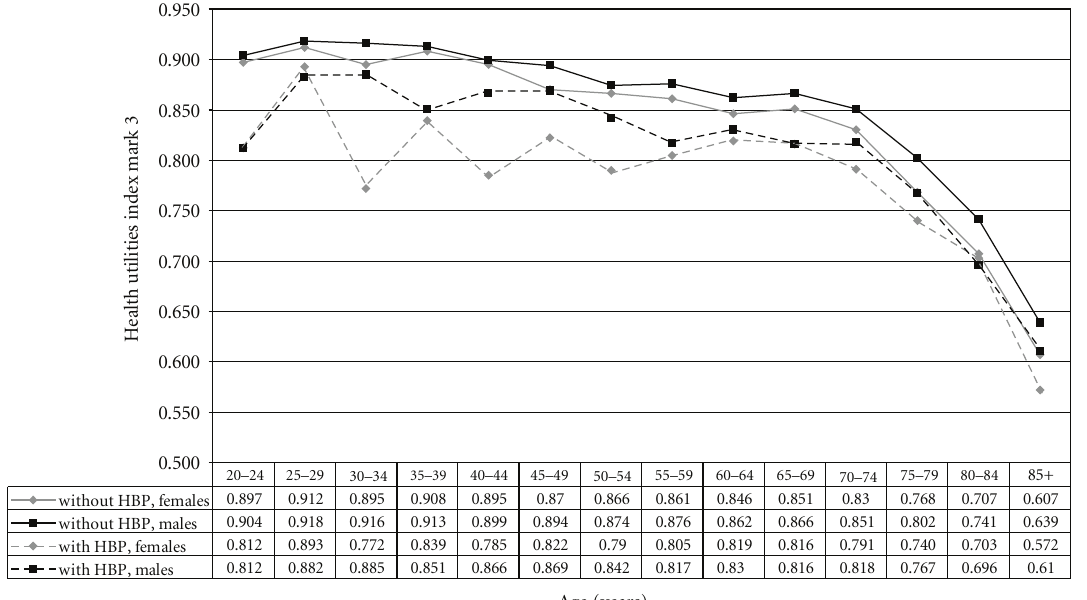
Figure 3: Health utilities index (HUI) for females and males with and without hypertension (HTN), Canada, 2000 to 2005. (Data source: Canadian Community Health Survey Data Files (CCHS) from Statistics Canada, 2000–2005. Dataset for this study excluded Quebec, Nunavut and Northwest